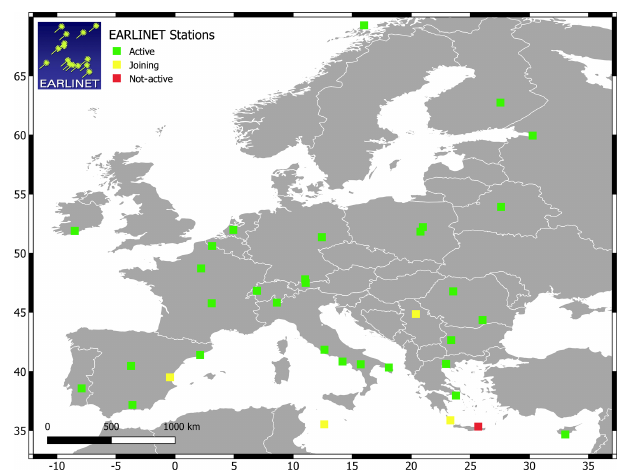
Figure 1. The EARLINET network in Europe. The green squares indicate the active stations, the yellow squares indicate the join- ing stations, and the red square indicates the non-active Finokalia, Greece,